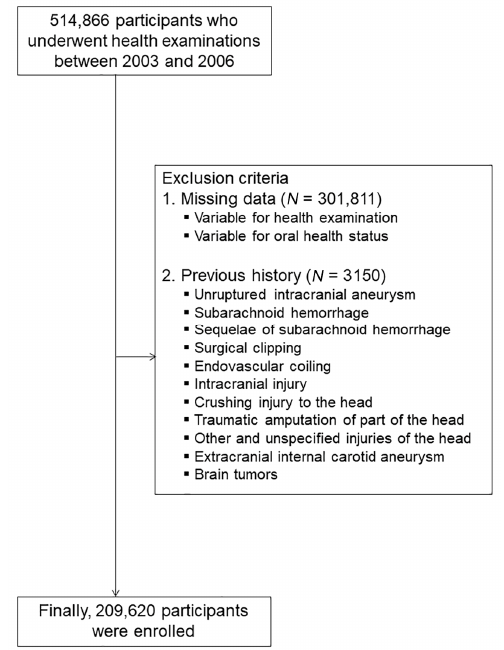
Figure 1. Flowchart of the study participants.